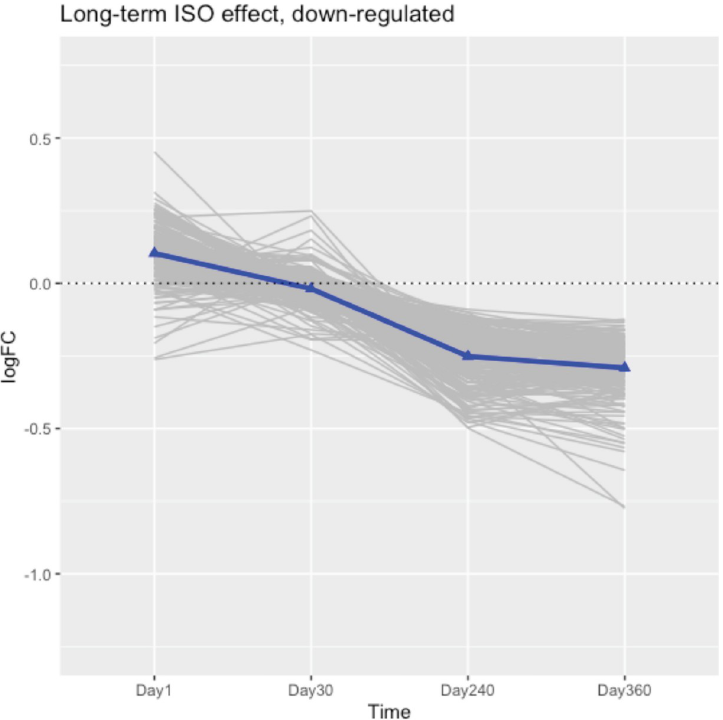
Fig 11. Trajectories of logFC of significantly down-regulated genes that manifest at the late timepoints. The 199 consistently down-regulated genes have FDR adjusted p-values < 0.05 at Day 360 and p < 0.1 at Day 240. Trajectories of individual genes plotted as grey lines. Blue lines connecting blue triangles are the mean trajectory. Groups of rats exposed to air (na ï ve, n = 6/each timepoint group) or ISO (n = 5/Day 1 group, and n = 6/Day 30, 240, and 360 groups) were used.